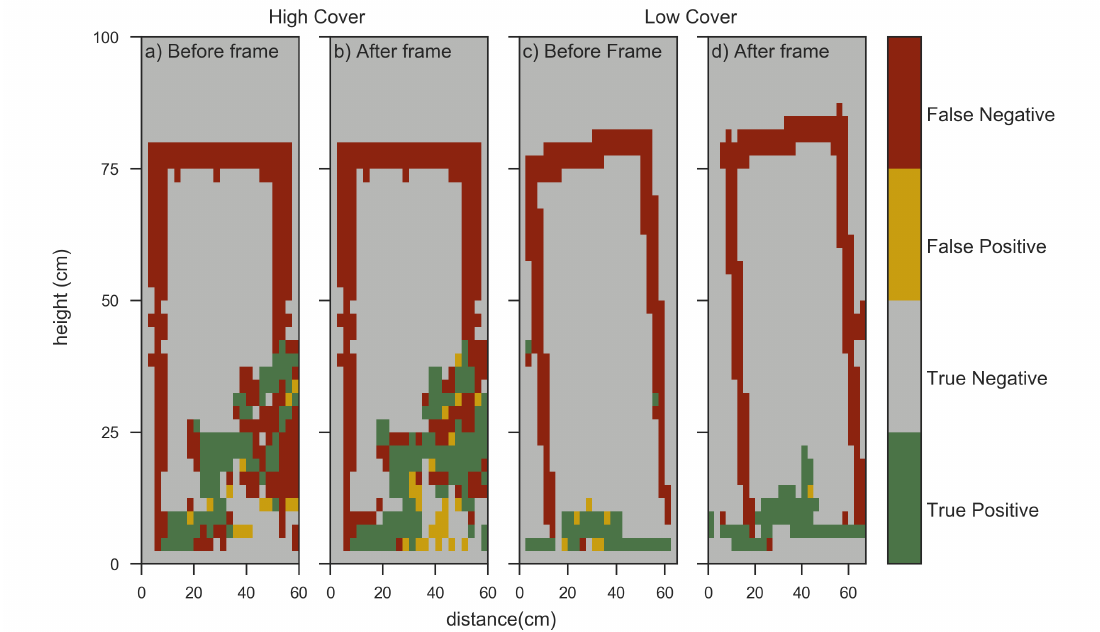
Figure 4. Visualisations of the agreement between point cloud data captured at high cover and low cover plots using SfM workflows. The differences are shown between point clouds with and without the frame in place: ( a , c ) the comparison to the point cloud captured before the frame was introduced; and ( b , d ) the comparison after to the point cloud captured after the frame was